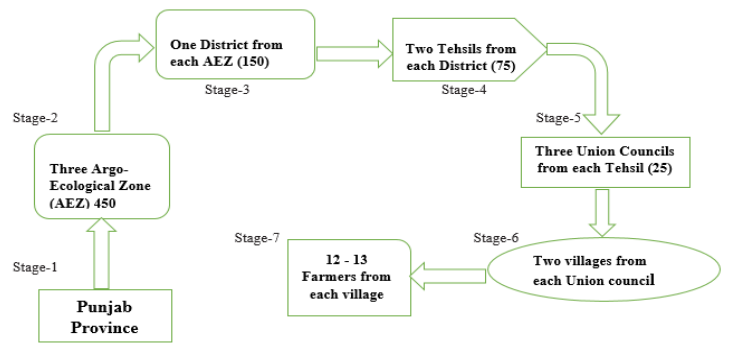
Figure 3. Sampling Figure 3. Sampling framework Figure 3. Sampling framework